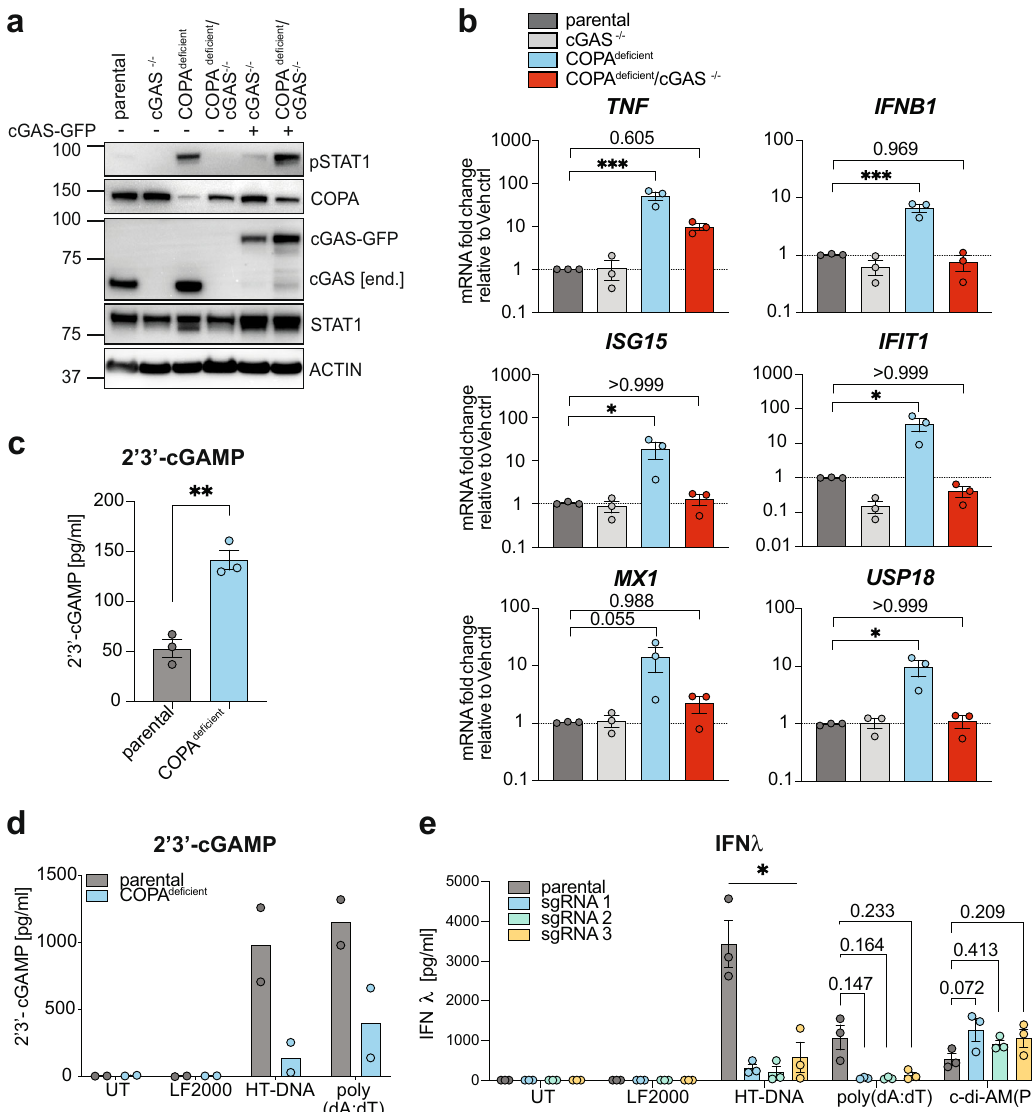
Fig. 4 In fl ammatory signalling in COPA de fi cient THP-1 cells requires cGAS. a Immunoblot analysis of parental THP-1 cells and monoclonal cGAS − / − THP- 1 cells following genetic deletion of COPA and reconstitution with cGAS-GFP via lentiviral transduction. Cells were treated with Dox for 72 hrs. A representative experiment is shown ( n = 2). end.; endogenous. b qRT-PCR analysis of baseline ISGs and proin fl ammatory gene transcription pro fi le in THP- 1 cells with indicated genotypes. Data are mean ± SEM from 3 independent experiments. Statistical signi fi cance was assessed by one-way ANOVA with Dunnett ’ s multiple comparison test. c Baseline analysis of 2 ’ 3 ’ -cGAMP levels in cell lysates of parental and COPA de fi cient THP-1 cells by ELISA. Data are shown as mean ± SEM from 3 independent experiments. Statistical testing by two-tailed unpaired Student ’ s t -test. d COPA de fi cient THP-1 cells were stimulated with cGAS activators HT-DNA (2 µ g/ml) and poly (dA:dT) (1 µ g/ml) for 24 hrs and 2 ’ 3 ’ -cGAMP levels in cell lysates measured by ELISA. Data are presented as mean from n = 2 independent experiments showing individual data points. e 3 different COPA syndrome model THP-1 cell lines (generated and described in Fig. 1a) were stimulated with HT-DNA (2 µ g/ml), poly (dA:dT) (1 µ g/ml) as well as STING activator c-di-AM(PS) 2 (20 µ M) for 24 hrs. Supernatants were analysed for released IFN λ by ELISA. Data are mean ± SEM from 3 independent experiments. Statistical signi fi cance was assessed by one-way ANOVA using parental cells as comparator group individually for each stimulus. P values are indicated by numbers or as * P < 0.05 , ** P < 0.01 , *** P < 0.001 . Lipofectamine 2000, LF2000. Source data are provided as a Source Data fi le for Fig.